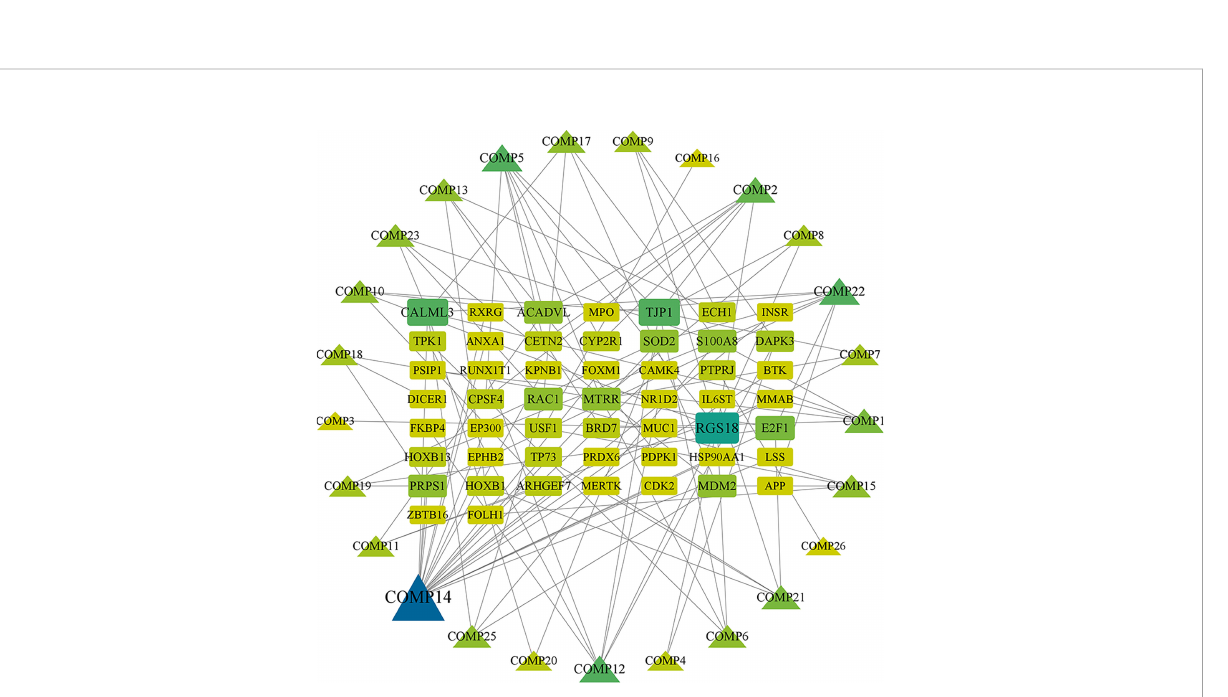
FIGURE 2 RXLD-related GBM targets ’ network. The symbols that are larger and linked to more edges represent targets of higher importance in the network.